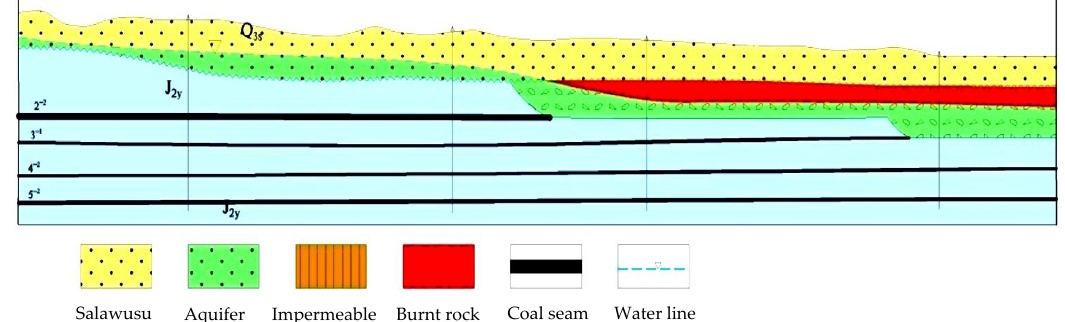
Figure 1. Sectional view of workable coal seams from Zhangjiamao Coal Mine in SFDFC, China.